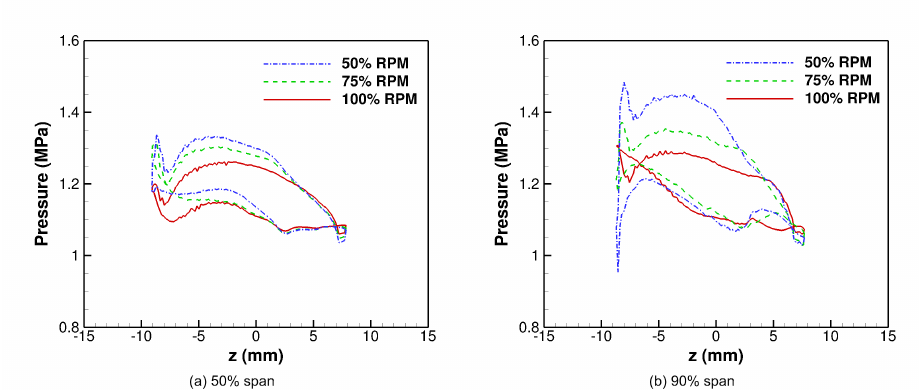
Figure 17. Mean pressure profiles along the rotor blade surface for different rotating speeds at: ( a ) 50% span of the rotor blade; and ( b ) 90% span of the rotor